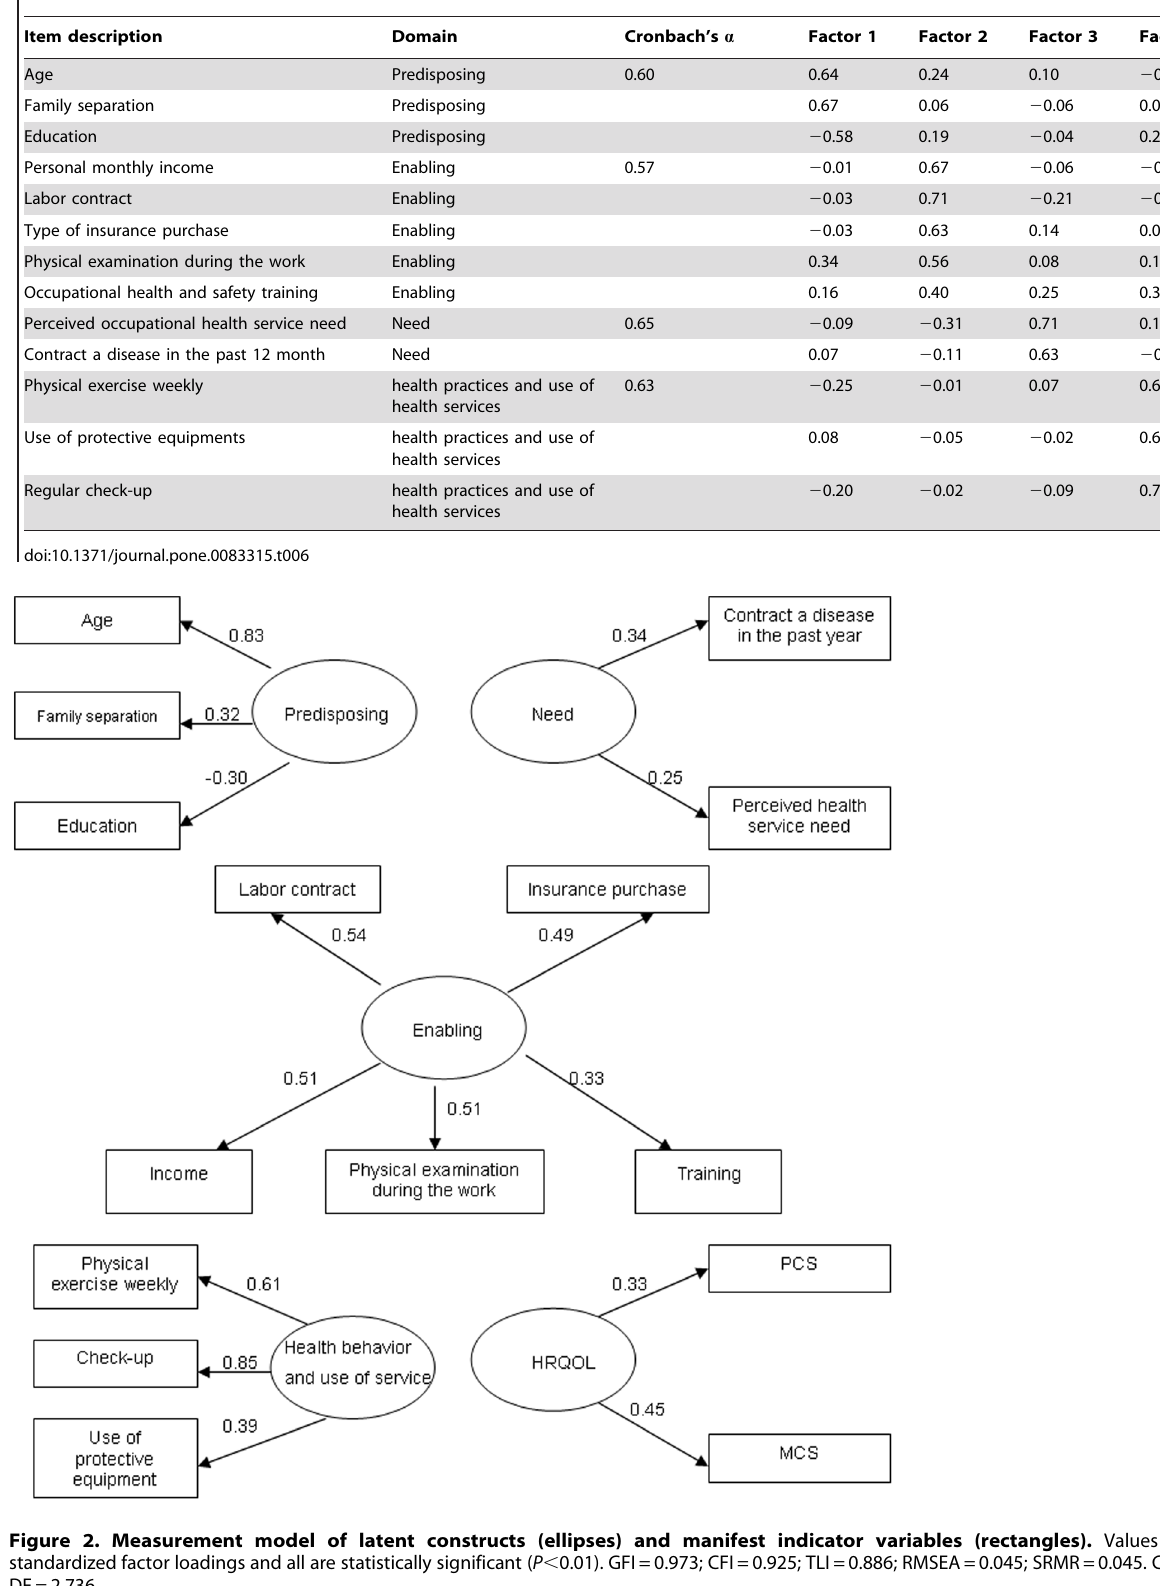
Table 6. The reliability and validity of measured variables (N=856).